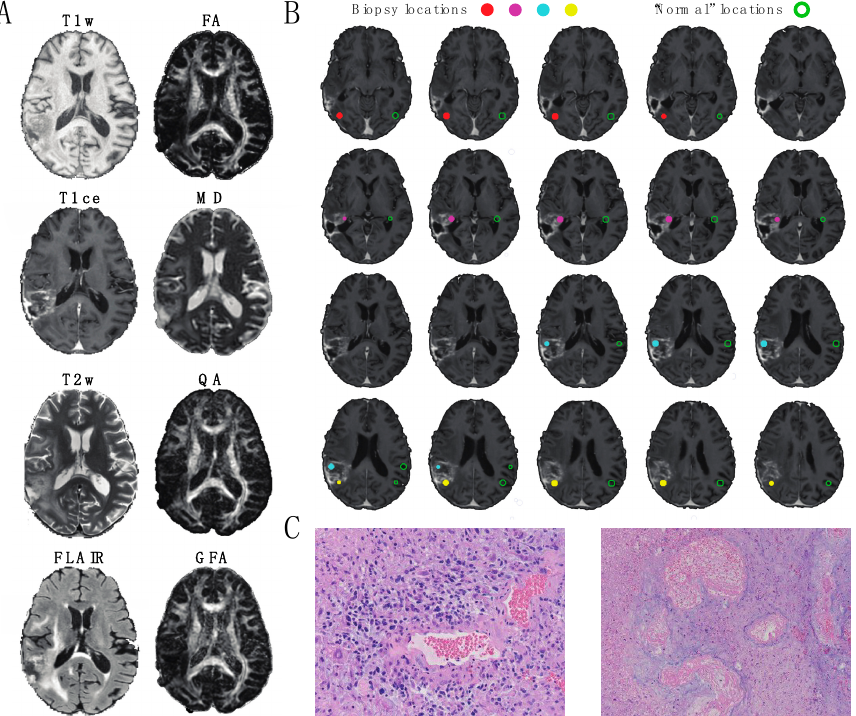
Figure 1. A 59-year old male patient with glioblastoma multiforme. ( A ) Axial slices of the image modalities explored in this study, comprised of four standard MRI metrics (T1w, T1ce, T2w, FLAIR = fluid-attenuated inversion recovery) and four diffusion MRI metrics (fractional anisotropy (FA) and mean diffusivity (MD) quantitative anisotropy (QA) and generalized fractional anisotropy (GFA)). ( B ) Depiction of biopsies from the patient shown in (A). Filled circles indicate the locations of 0.5 mm 3 Regions of Interest (ROIs) representing tissue extractions. Open circles indicate the locations of anatomically similar locations of 0.5 mm 3 ROIs in the normal appearing (“healthy”) contralateral hemisphere. For this patient, one biopsy (red) consisted primarily of abnormal tissue and three biopsies (magenta, cyan, and yellow) consisted primarily of tumor tissue. ( C ) Example slides of histopathology used in classification. (Left image) Tumor: Infiltrating high-grade glioma is seen with cytologically pleomorphic nuclei with large areas of necrosis and thick hyalinized blood vessels (20× magnification). (Right image) Abnormal: cortical white matter with extensive gliosis and neuropil vacuolization. Regional necrosis with thick hyalinized blood vessels consistent with radiation necrosis is present (10× magnification). (Figure 2A), differences were detected between Abnormal and Tumor in the T1ce and T2w signals (Tukey’s post-hoc test, Family Wise Error Rate (FWER) = 0.05) and between Tumor and Normal in the T1w, T1ce, T2w, FLAIR, FA, and MD signals (Tukey’s post-hoc test, FWER = 0.05). No differences were detected between Abnormal and Normal. For RT patients (Figure 2B), fewer image features were deemed statistically different. No differences were detected between Abnormal and Tumor (Tukey’s post-hoc test, FWER = 0.05), one difference was detected between Tumor and Normal in the T1ce signal (Tukey’s post-hoc test, FWER = 0.05), and two differences were detected between Abnormal and Normal in FLAIR and MD signals. The only difference consistent among treatment groups was between Tumor and Normal for the T1ce image modality; though, the feature